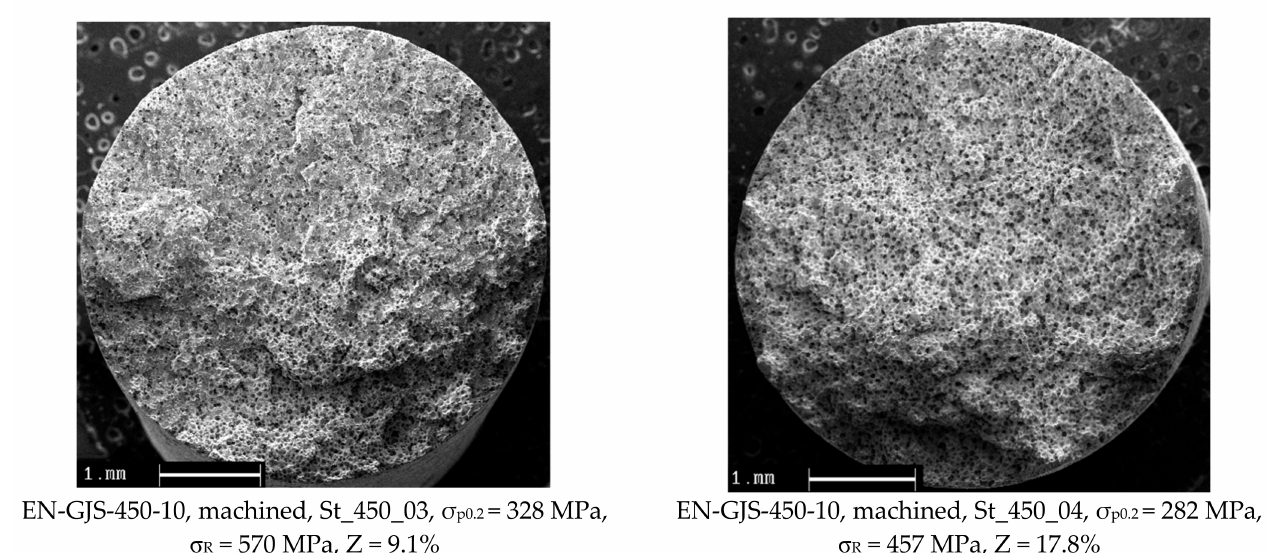
Figure 13. Fracture surfaces of plain cylindrical specimens (Figure 4) after static tensile